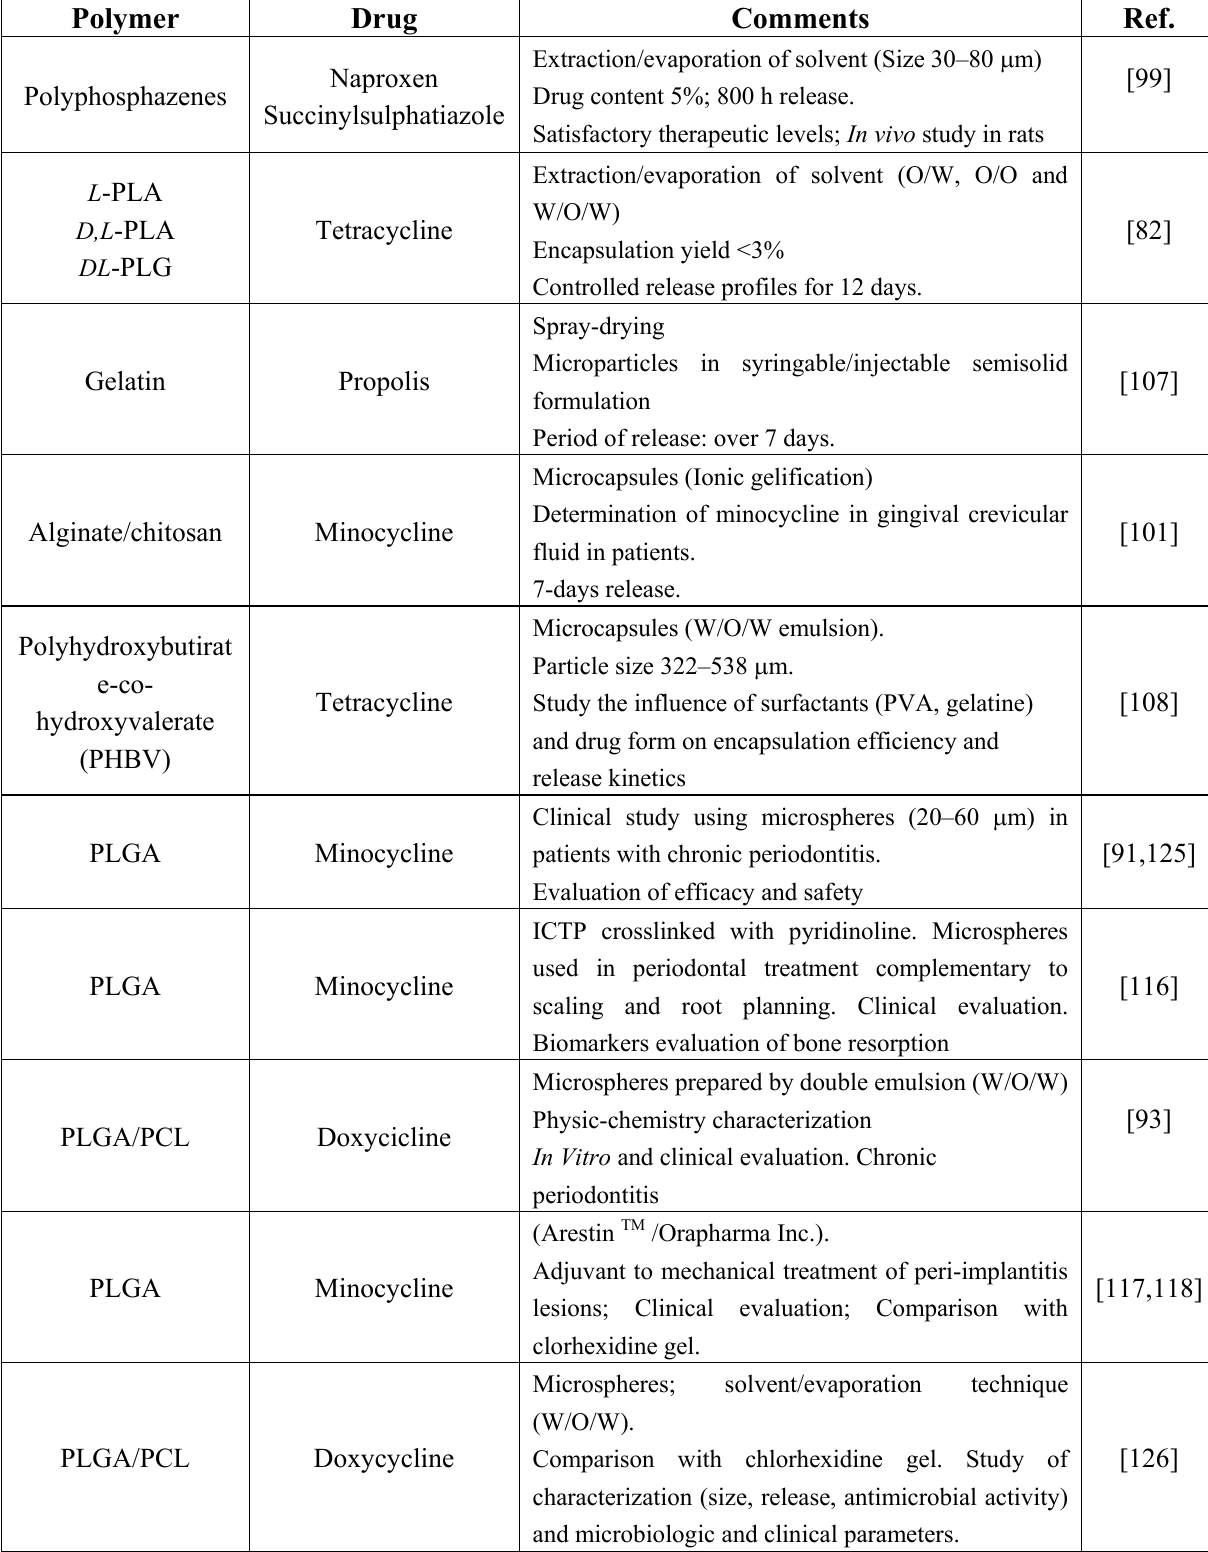
Table 1. Overview of most widely studied polymers for preparation of microspheres for periodontal applications and studies where they were